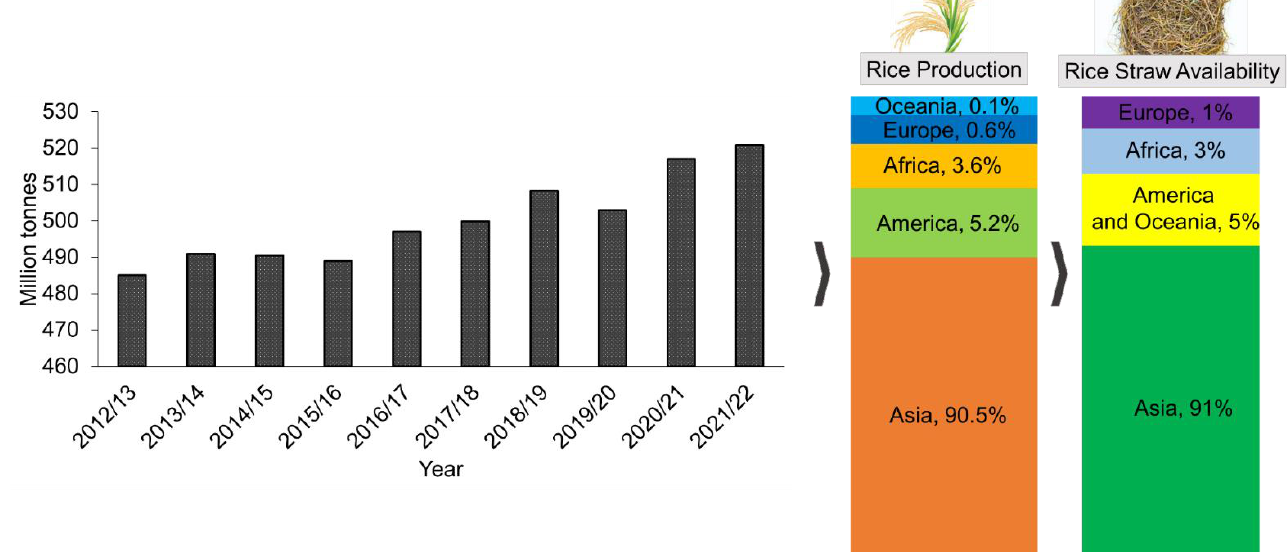
Figure 1. Global rice production. [3,16].